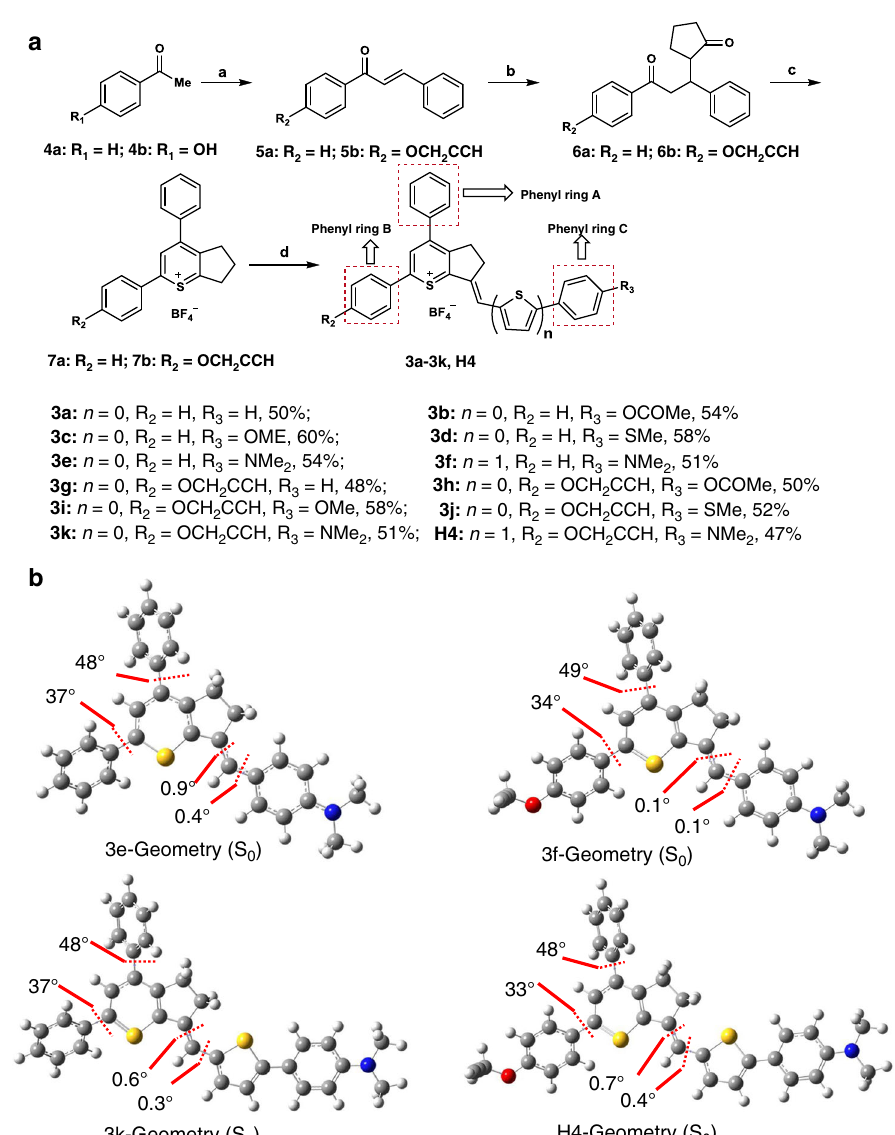
Fig. 2 Synthetic route of 3a – 3k, H4 and the calculated optimized geometries of 3e – 3k, H4. a Reagents and conditions: a (i) acetophenone, benzaldehyde, 3 M aqueous KOH, EtOH, 25 °C, 14 h, 5a: 80%; 1-(4-hydroxyphenyl)ethan-1-one: 82%; (ii) K 2 CO 3 , 3-bromoprop-1-yne, acetone, re fl ux 4 h, 5b: 97%; b (i) cyclopentanone, pyrrolidine, benzene, 100 °C, 4 h; (ii) compound 5, dioxane, re fl ux, 6 h, 6a: 68%; 6b: 66%; c thioacetic acid, boron tri fl uoride ether, ether, 60 °C, 2 h, 7a: 62%; 7b: 50%; d aldehydes, acetic anhydride, 70 °C, under microwave irradiation, 75 °C, 2 h, 47 – 60%. b Calculated optimized ground state ( S 0 ) geometries of the molecules at the B3LYP/6-31 G ( d ) level (Gaussian 09, Revision